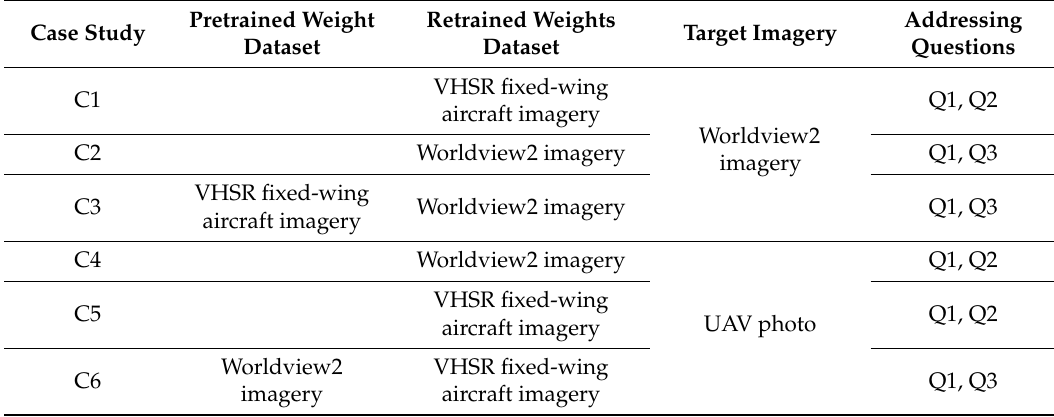
Table 2. Description of case studies and their corresponding research questions. Pretrained Weight Retrained Case Study Dataset